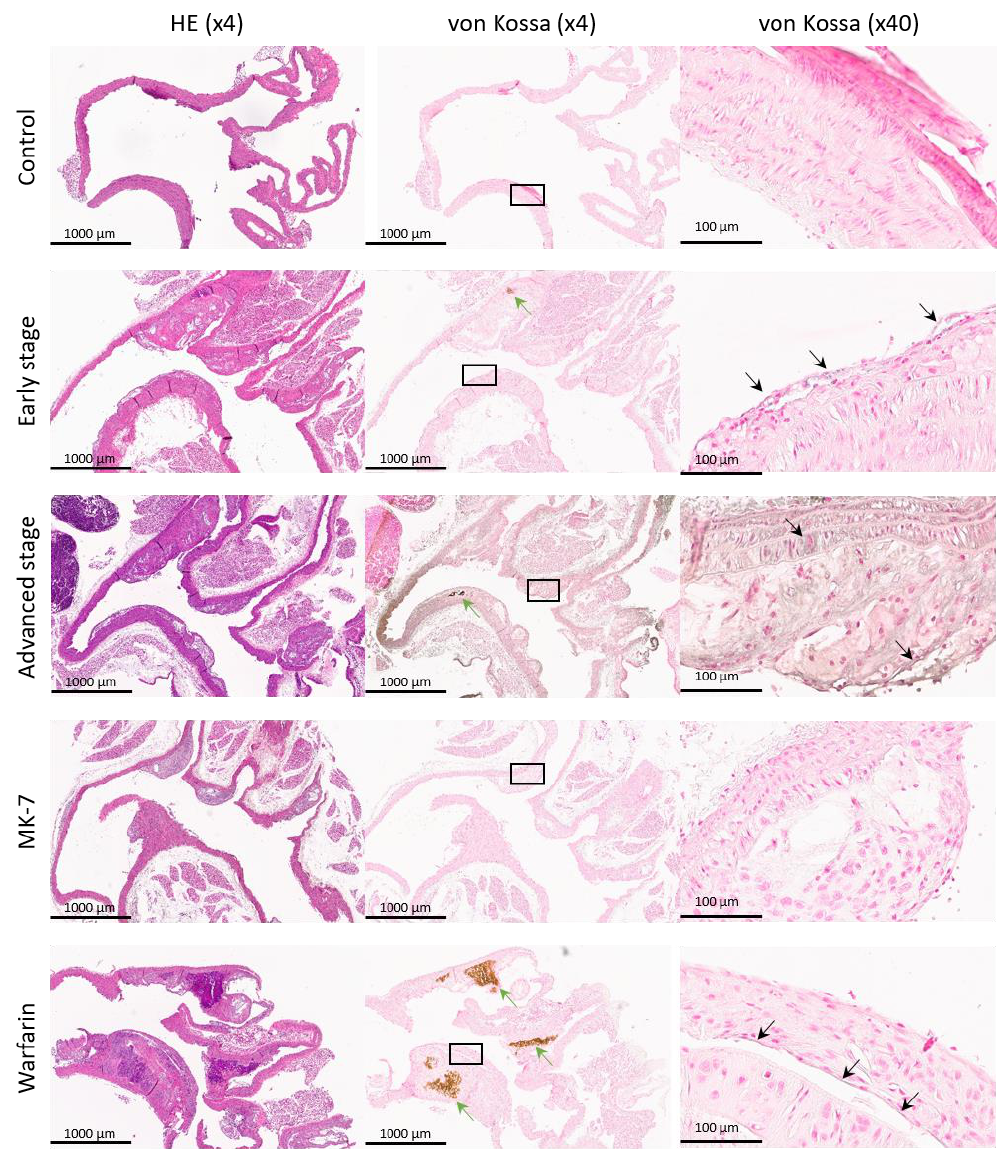
Figure 2. Validation stainings: example of an aortic arch Hematoxylin eosin (HE) and von Kossa stainings from each experimental group. The first image column is stained with HE followed by the next paraffin slice, which is stained with von Kossa (green arrows indicate calcifications larger than 50 μm). The von Kossa (×40) column contains representative enlargements with sites of microscopic calcification (black arrows indicate calcifications smaller than 50 μm).